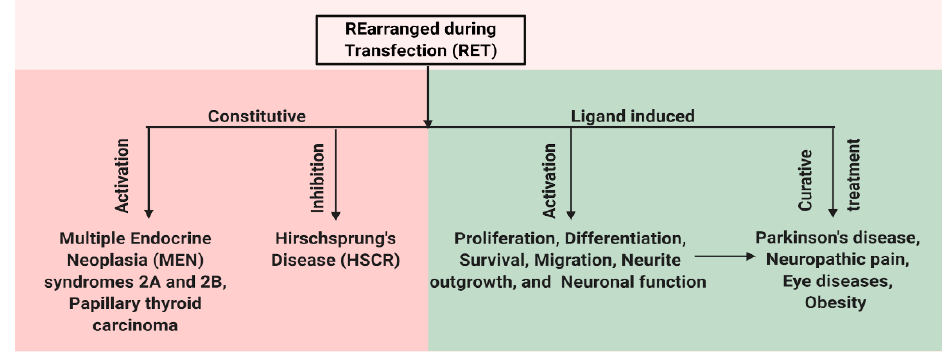
Figure 2. Schematic representation of multiple facets of RET protein. RET has a role in both disease and normal state. Constitutive activation of RET by mutations leads to human multiple endocrine neoplasia (MEN) syndromes 2A and 2B, while mutations that inhibit RET activation can cause Hirschsprung disease (HSCR). Ligand-based activation of RET is essential for the development of both peripheral and central nervous systems and also outside the nervous system. Therefore, targeting RET with agonists can be a useful approach in the treatment of neurodegenerative diseases and obesity, and RET antagonists may have a role in the therapy of RET-dependent cancers.